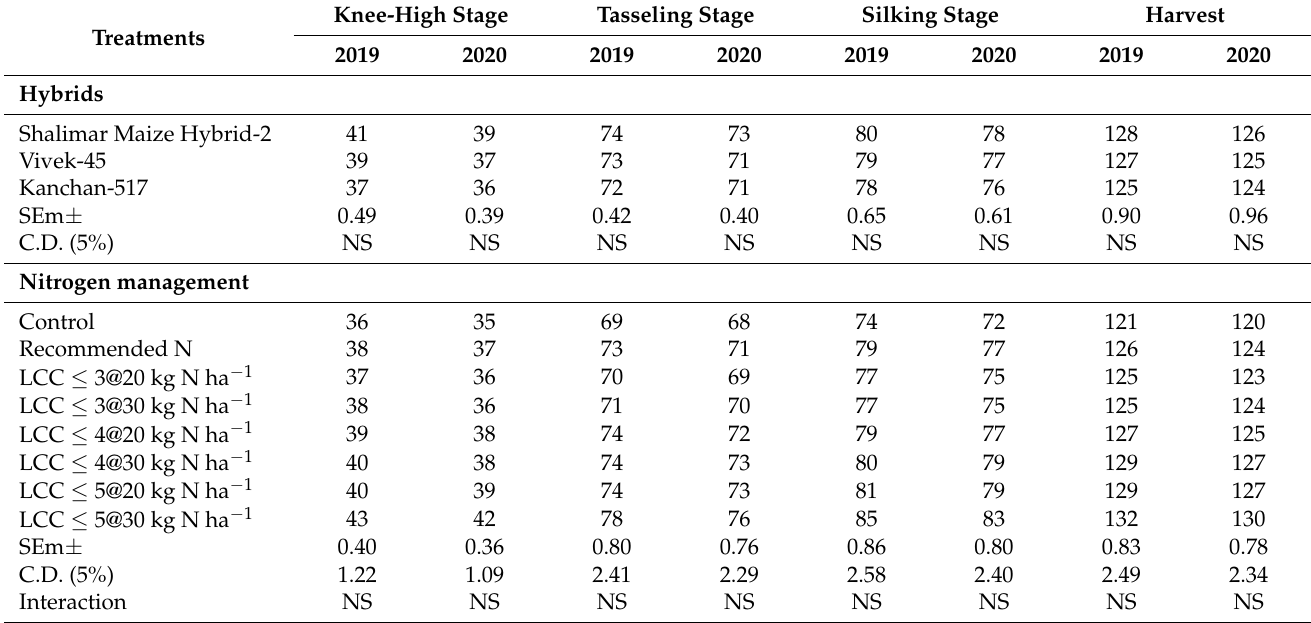
Table 3. Effect of precision nitrogen management through LCC on days taken to different phenophases of different hybrid maize